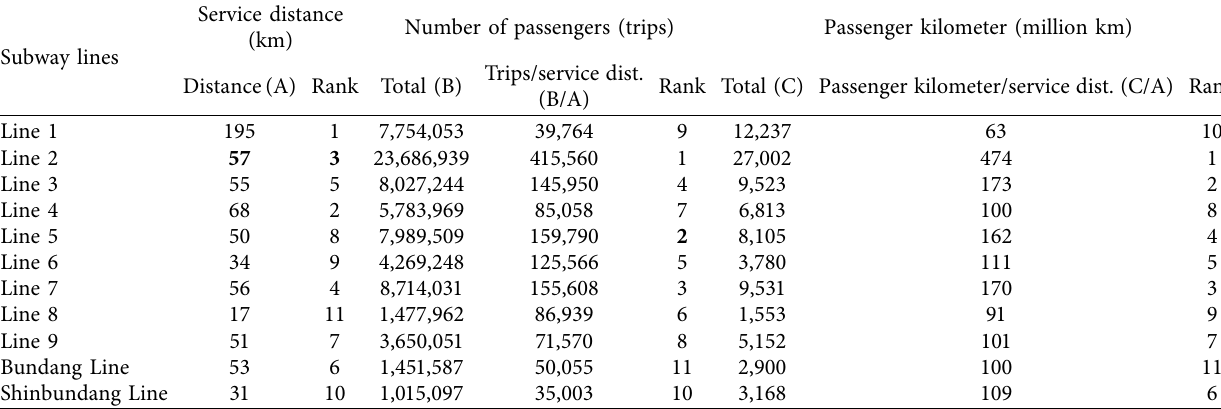
Table 7: Results of passenger kilometer for subway lines in